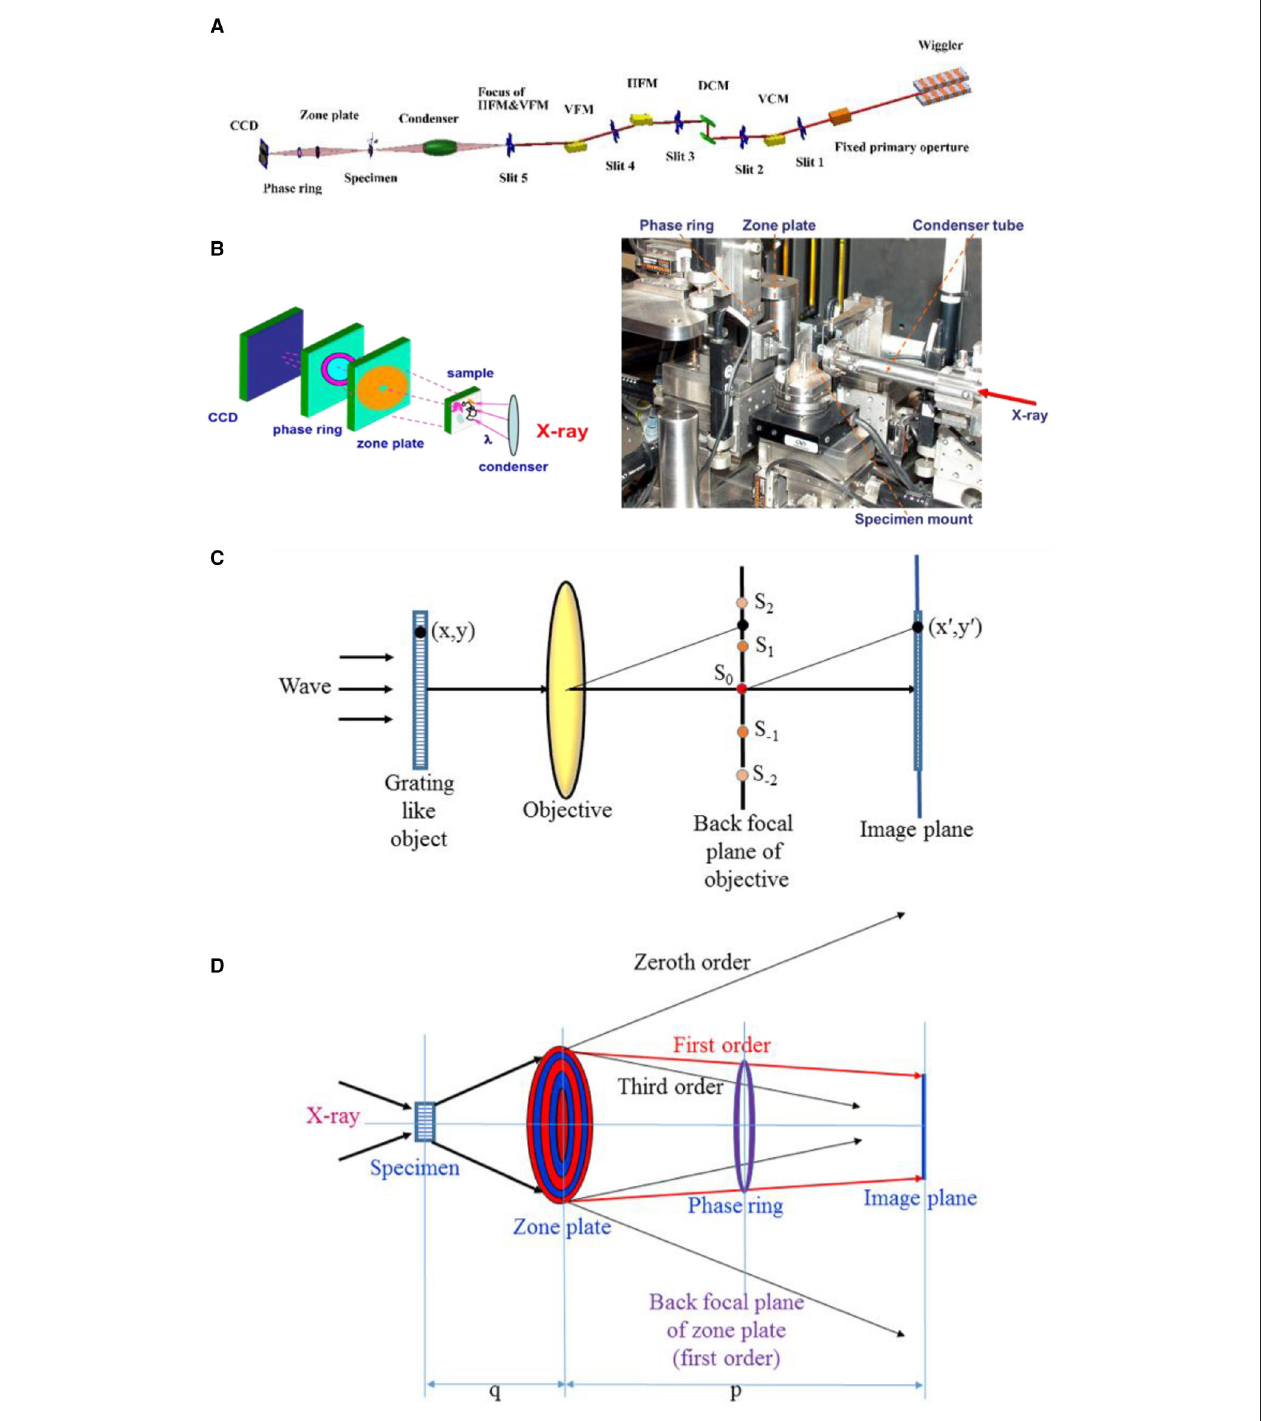
FIGURE 1 | (A) Layout of synchrotron radiation transmission X-ray microscopy (TXM) beamline. (B ) Sketch (left) and photograph (right) of the TXM instrument. (C) Sketch of Abbe theory for image formation in a microscope. (D) Sketch of the zone plate and phase ring in the TXM instrument. The zone plate consists of concentric circle zones with Au (or other metal) (red circles) and Si 3 N 4 (blue circles) replacements. The phase ring material is gold.